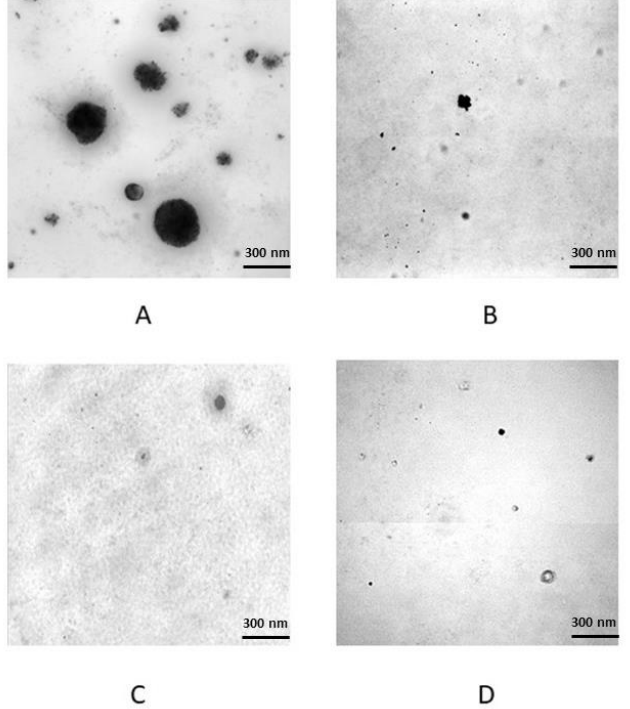
Figure 1. The representative colonies in soft agar colony formation assay: ( A ) HEK293T + PDAC serum; ( B ) hTERT-HPNE + PDAC serum; ( C ) HEK293T + healthy donor serum; ( D ) hTERT-HPNE + healthy donor serum. Note that the horizontal lines in ( B , D ) figures were caused by rolling shutter modality of the microscope camera (Hamamatsu ORCA-Flash4.0 LT).